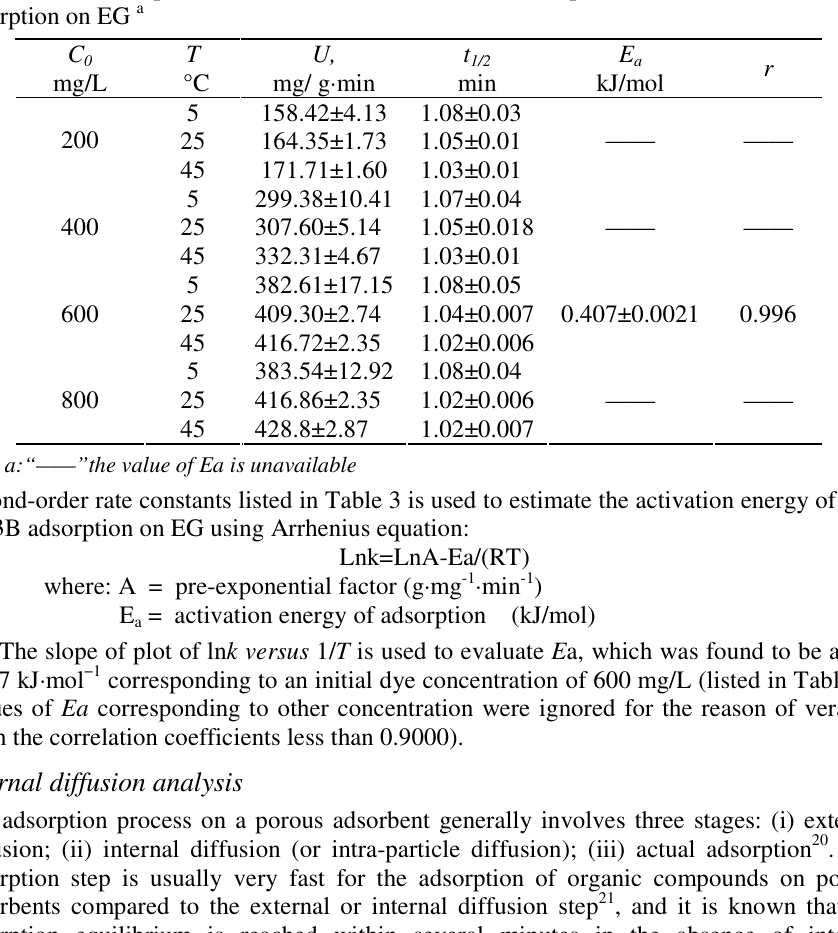
Table 4 . Kinetic parameters for the second-order adsorption model of acid red 3B adsorption on EG